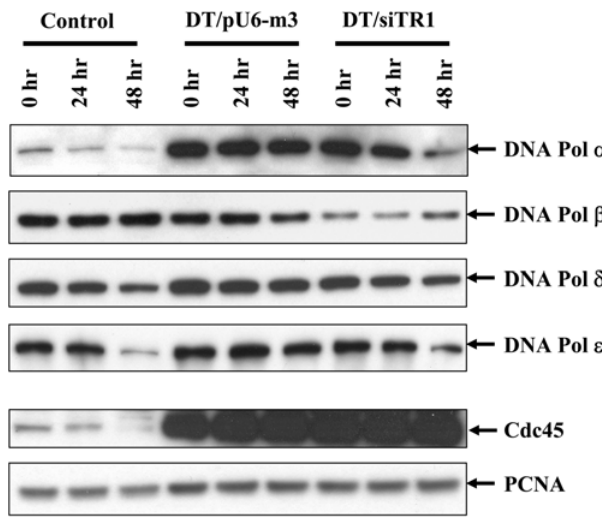
Figure 4. Analysis of components involved in DNA replication. Expression levels of DNA polymerase components, DNA Pol a , b , d and e , Cdc45 and PCNA, in control, DT/pU6-m3 and DT/siTR1 cells were analyzed by western blotting. Cells were grown in serum-deficient medium for 0, 24 and 48 hrs, harvested, protein cell extracts prepared and electrophoresed as described in